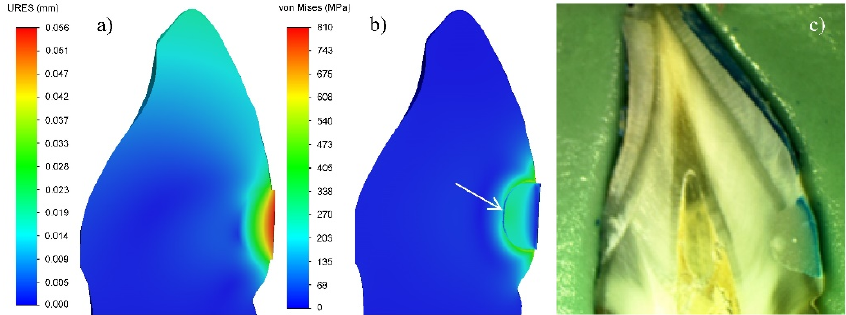
Figure 6. GIC filling of tooth cavity: ( a ) Displacement in the zone of filling; ( b ) Von Mises equivalent stresses; ( c ) Micro-leakage. (3% shrinkage).